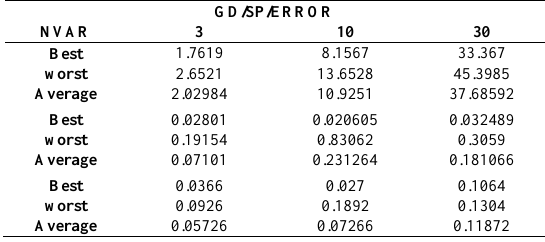
Table 12. GD/SP/ERROR analysis on the second